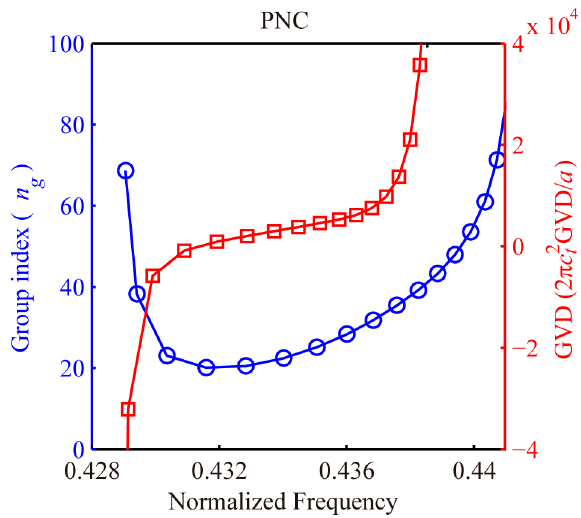
Figure 6. Variations of the group velocity and group velocity dispersion (GVD) with the frequency for the surface acoustic waves (SAW) band marked with yellow color in Figure 5a. Blue and red lines denote the group index and the GVD, respectively.